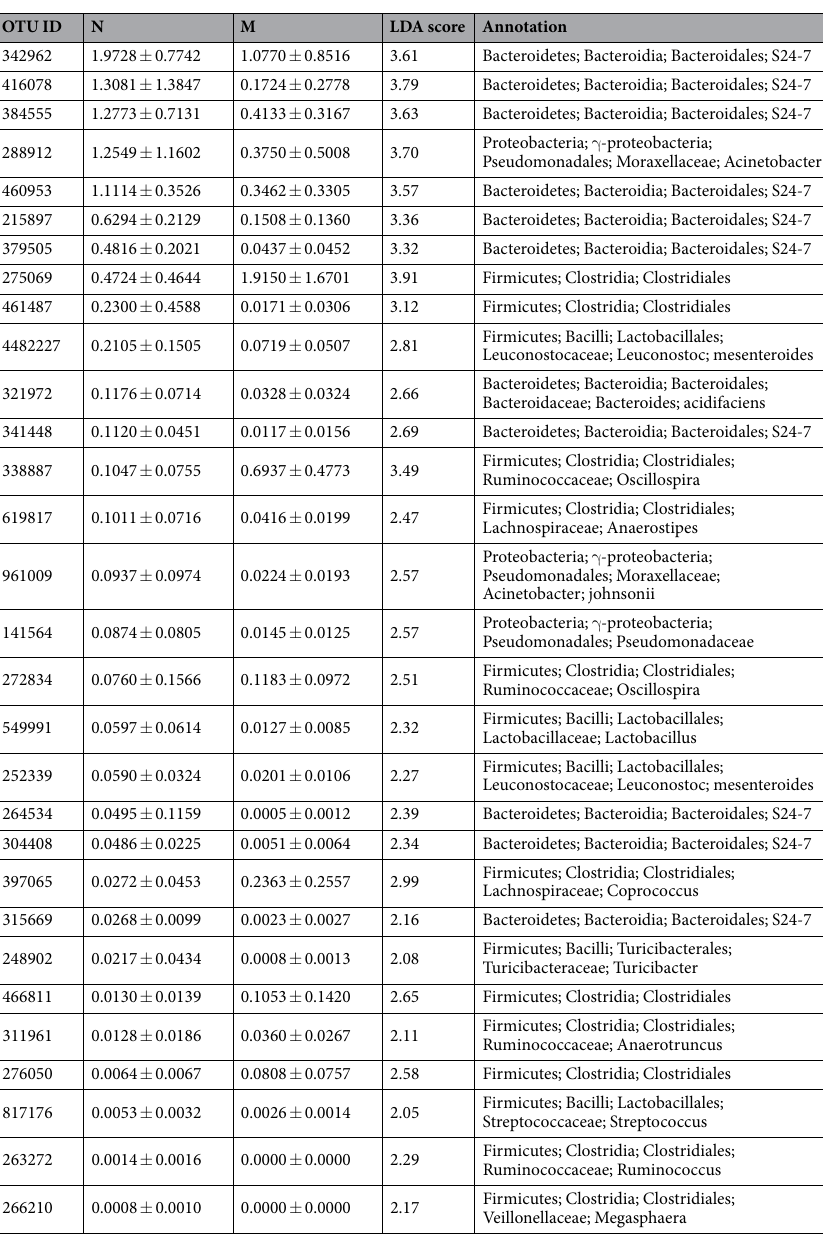
Table 2. OTU displaying significantly different abundance between healthy (N) and stressed (M) conditions. The numbers represented relative abundance (mean ± sd). The significance threshold is the absolute log 10 Linear Discriminant Analysis (LDA) score >